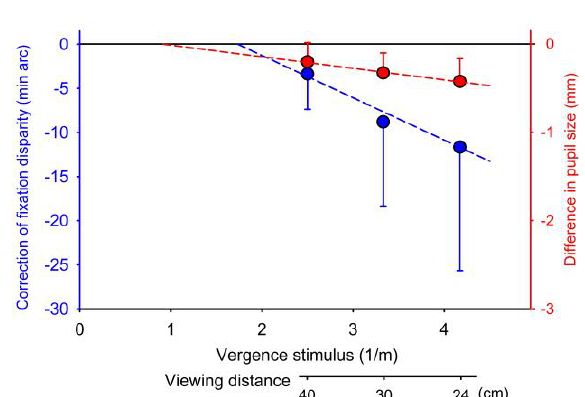
Figure 3: The viewing distance of the displays (24, 30, 40 cm) is indicated on the x-axis of the vergence stimulus which corresponds to the unit “meter angle” and is equivalent to 1/m. The difference in pupil size (mm) between the binocular test phase and monocular calibration phase is plotted in red (see right y-axis) and the amount of the correction of the fixation disparity is shown in blue (see left y-axis, i.e FD cor – FD raw ; see Figure 4. Negative numbers mean that the pupil is smaller in the binocular test phase and that the corrected fixation disparity is more exo than the raw fixation disparity. Data points and error bars refer to means and standard deviations of the two sessions